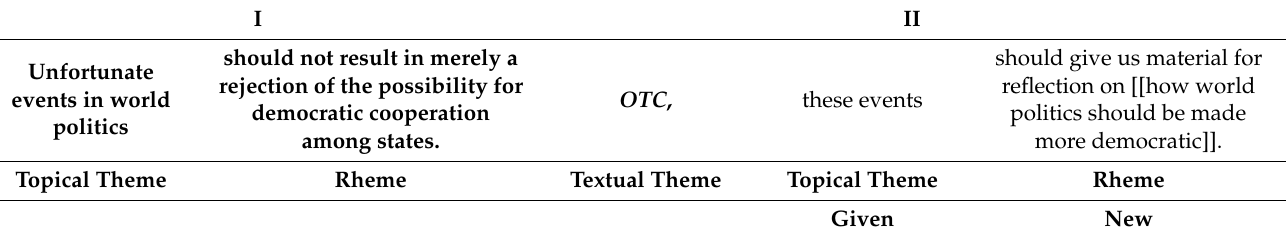
Table 2. Thematic analysis of example